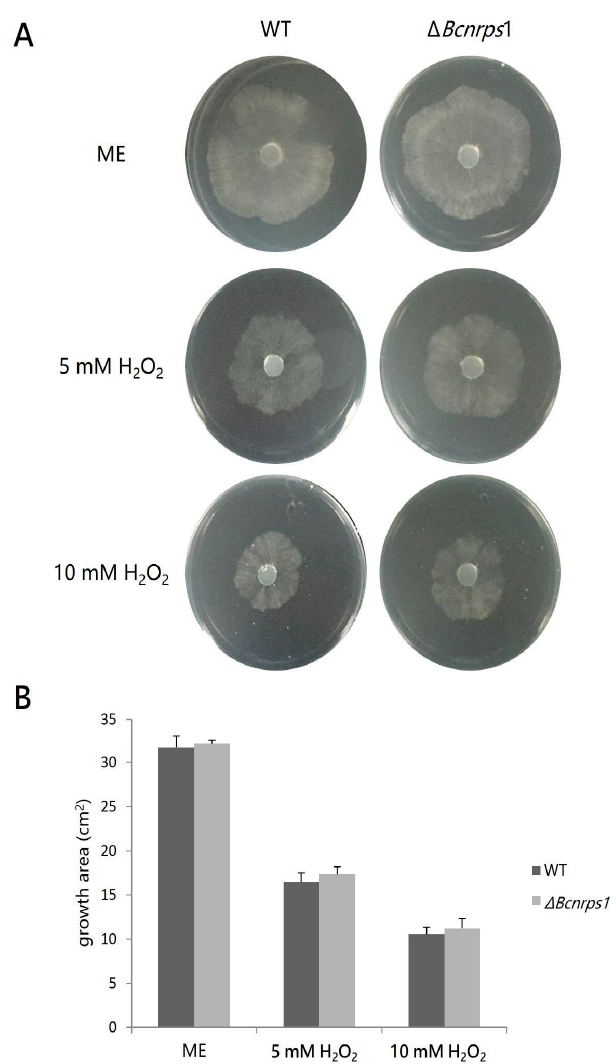
Figure 7. ( A ) Effect of hydrogen peroxide 4 dpi on the growth B. cinerea B05.10 (WT) strain and ∆ Bcnrps 1 mutant cultivated on malt extract (ME) medium without and with an increasing amount of hydrogen peroxide (H 2 O 2 ) (5 or 10 mM). ( B ) Growth area of the B. cinerea B05.10 (WT) (gray) and ∆ Bcnrps 1 (light gray) on oxidative stress-inducing media. ME: growth area in 0.2% ME medium; 5 mM H 2 O 2 and 10 mM H 2 O 2 : growth area in 0.2% ME amended with hydrogen peroxide 5 and 10 mM, respectively. Error bars represent standard deviations of means ( n = 3).